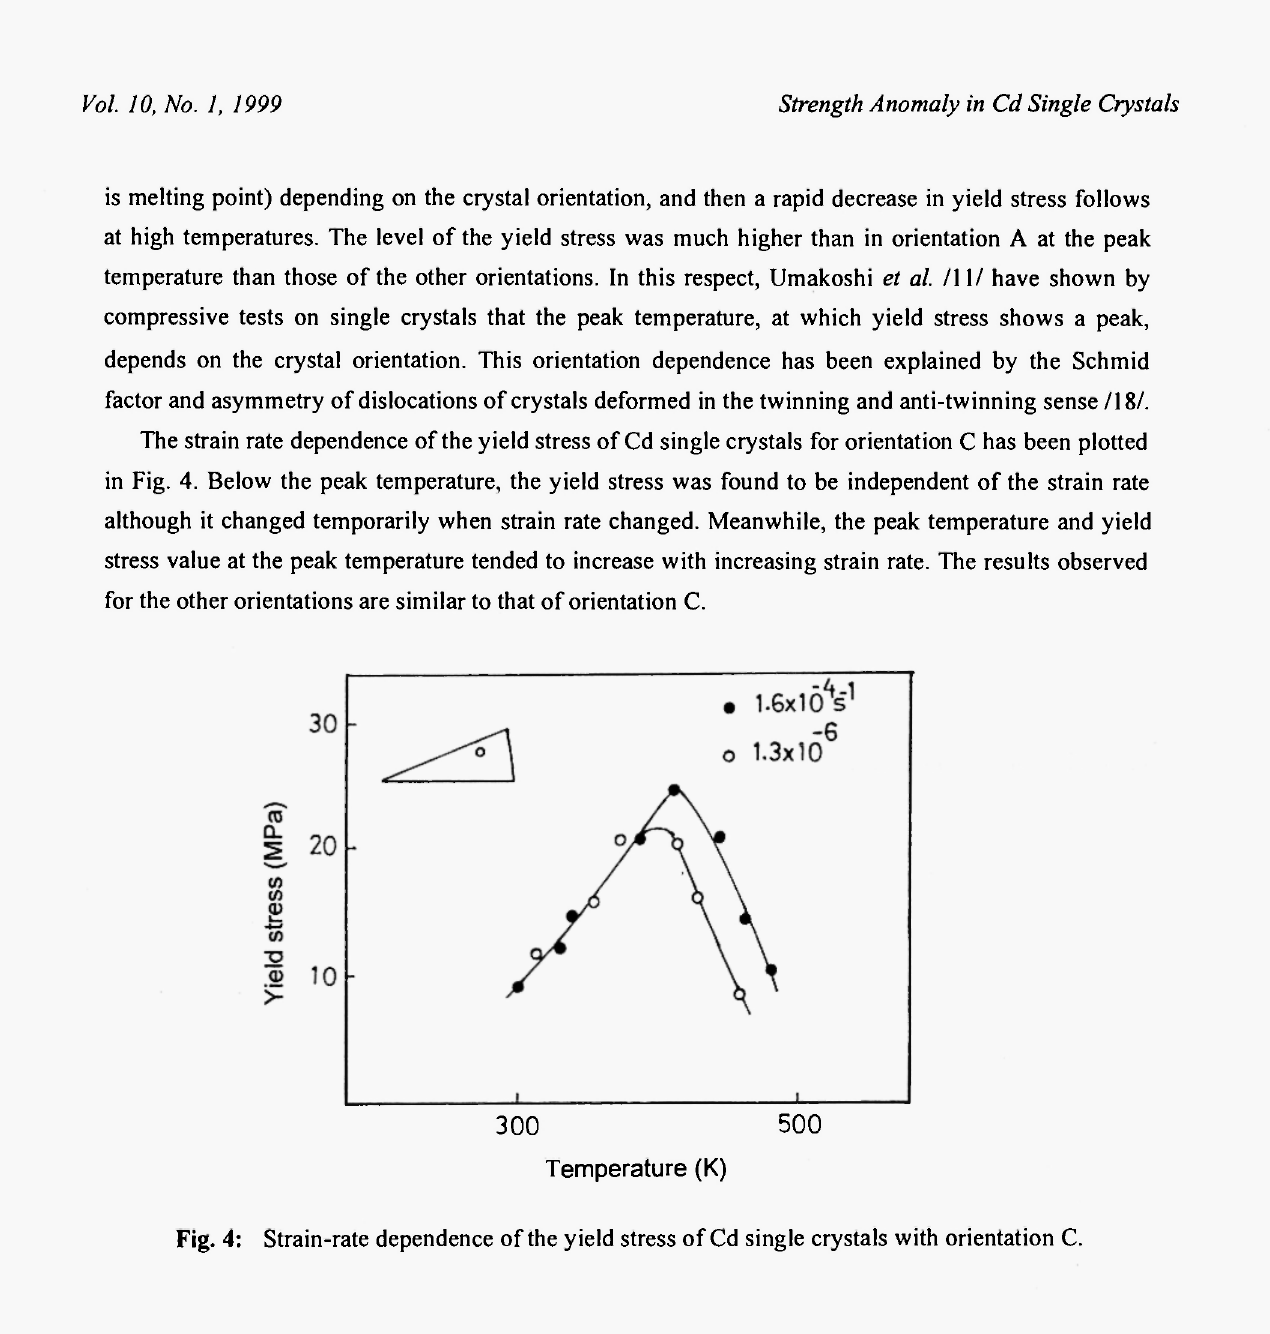
Fig. 4: Strain-rate dependence of the yield stress of Cd single crystals with orientation